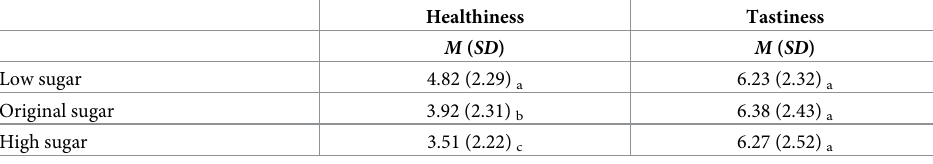
Table 3. Mean healthiness and tastiness ratings of products with low, original and high sugar level contents.